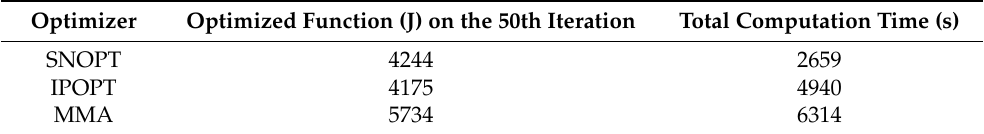
Table 2. Computational times for the three optimizers.